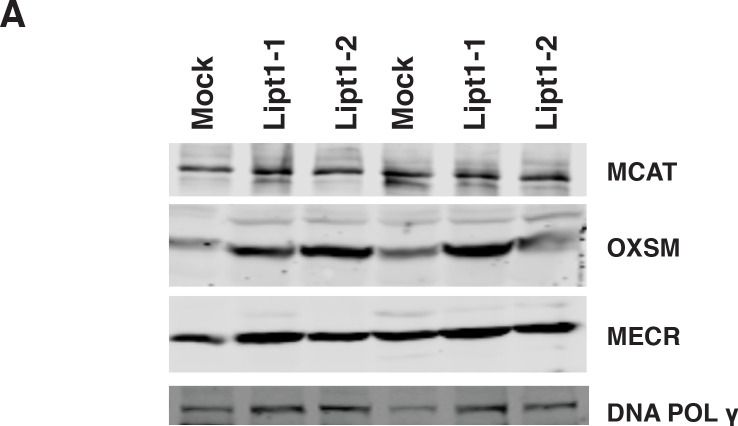
Expression of mtFAS proteins is unchanged in Lipt1 mutant cell lines.(A) Crude isolated mitochondrial proteins were isolated by SDS-PAGE and immunoblotted for MCAT, OXSM, and MECR, along with DNA polymerase gamma.